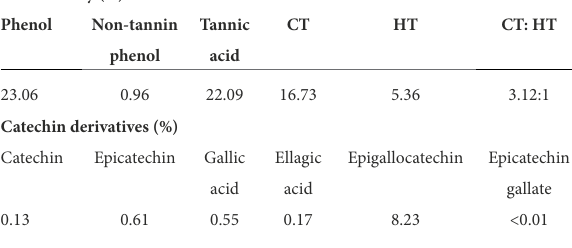
TABLE 1 Tannin assay and catechin derivatives in anti-methanogenic supplement.